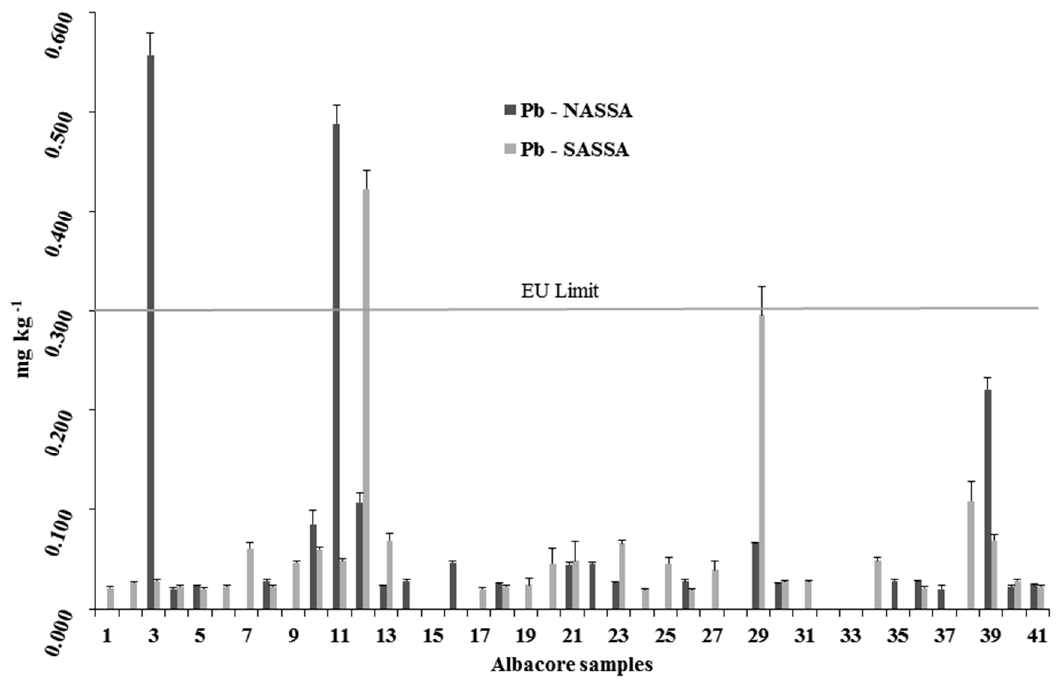
Figure 7. Lead concentrations in each individual T. alalunga , caught from NASSA and SASSA areas.